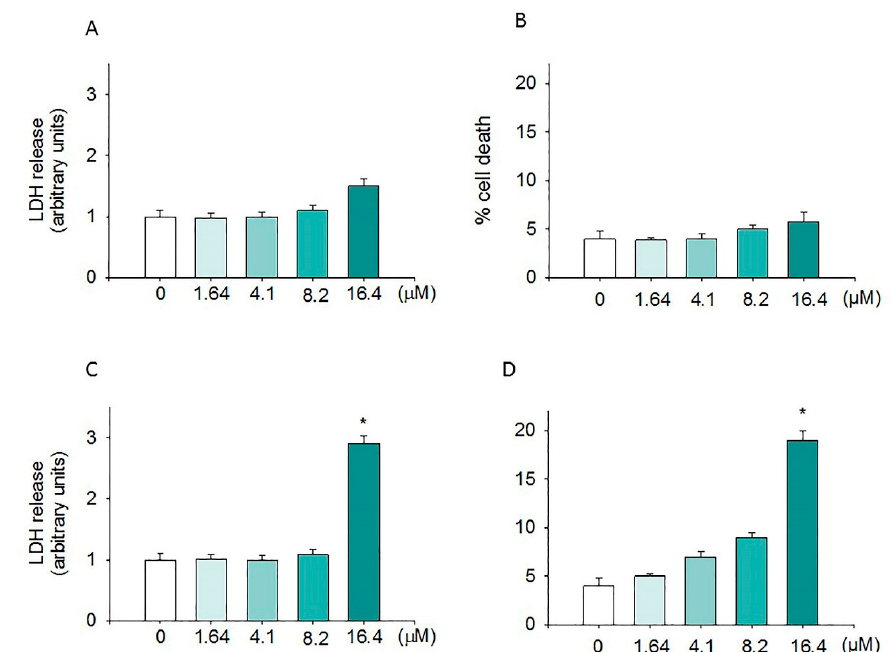
Figure 2. Cytotoxic effects of moringin. The cytotoxic activity of moringin (1.64–16.4 µM) was evaluated in terms of both LDH release ( A and C ) and cell death ( B and D ) after 24 h of exposure. LDH levels were extrapolated as the values detected in control cells which were arbitrarily expressed as 1. Cell death was reported as the percentage of blue stained (non-viable) vs. total cells counted. Data, expressed as mean ± SEM, represent the values obtained in three different sets of experiments made in triplicate. * p < 0.05 vs. control.